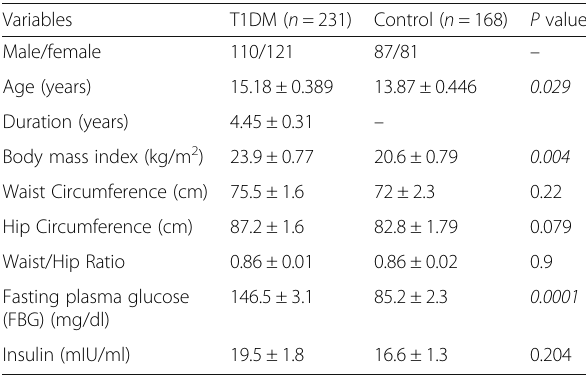
Table 1 Baseline characteristics of T1DM patients and control group